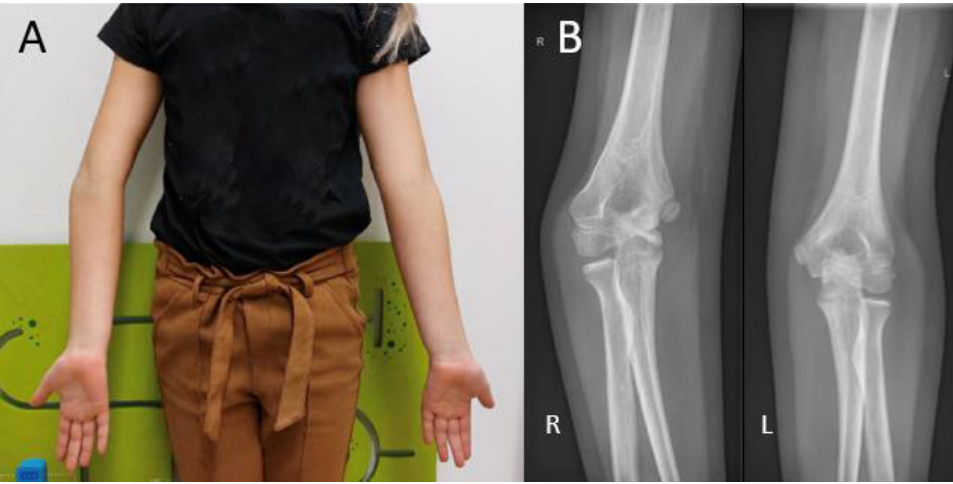
Figure 1. ( A ) Visual inspection of the carrying angle of the elbow in a 10-year-old girl showing a unilateral cubitus varus on the right side. ( B ) Anteroposterior radiographic views of the elbow with the unaffected contralateral side for